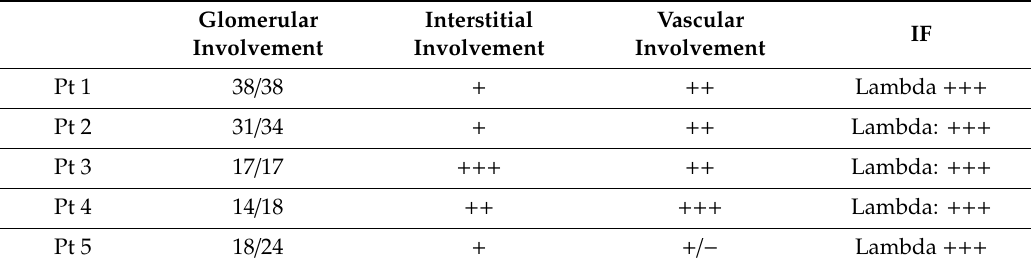
Table 3. Distribution of amyloid deposits in the kidney (biopsy performed before starting